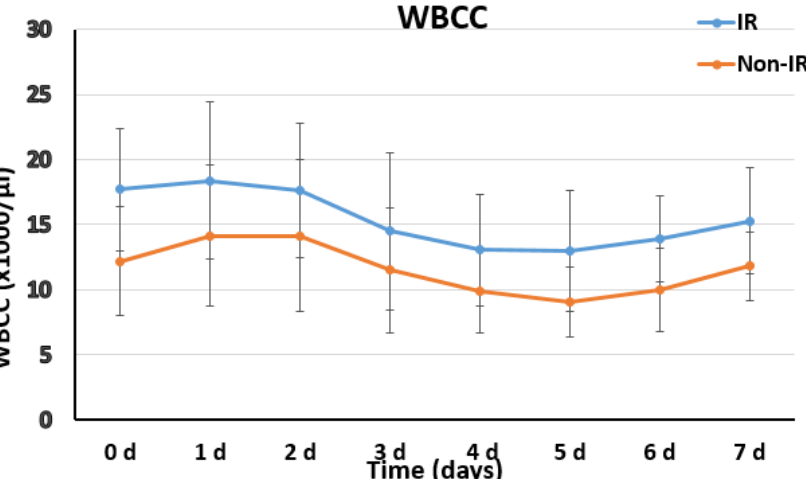
Figure 4. Postoperative distribution and trends of the white blood cell count (WBCC) in the IR and non-IR group.